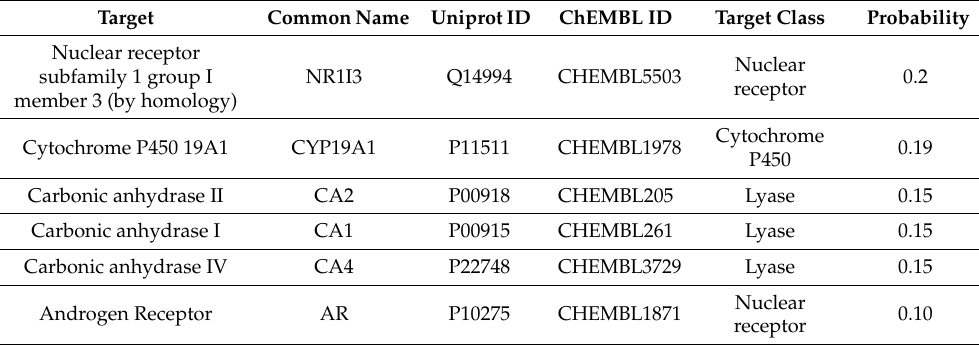
Table 9. Main molecular targets of the phytochemical camphor obtained through the analysis in Swiss Target Prediction